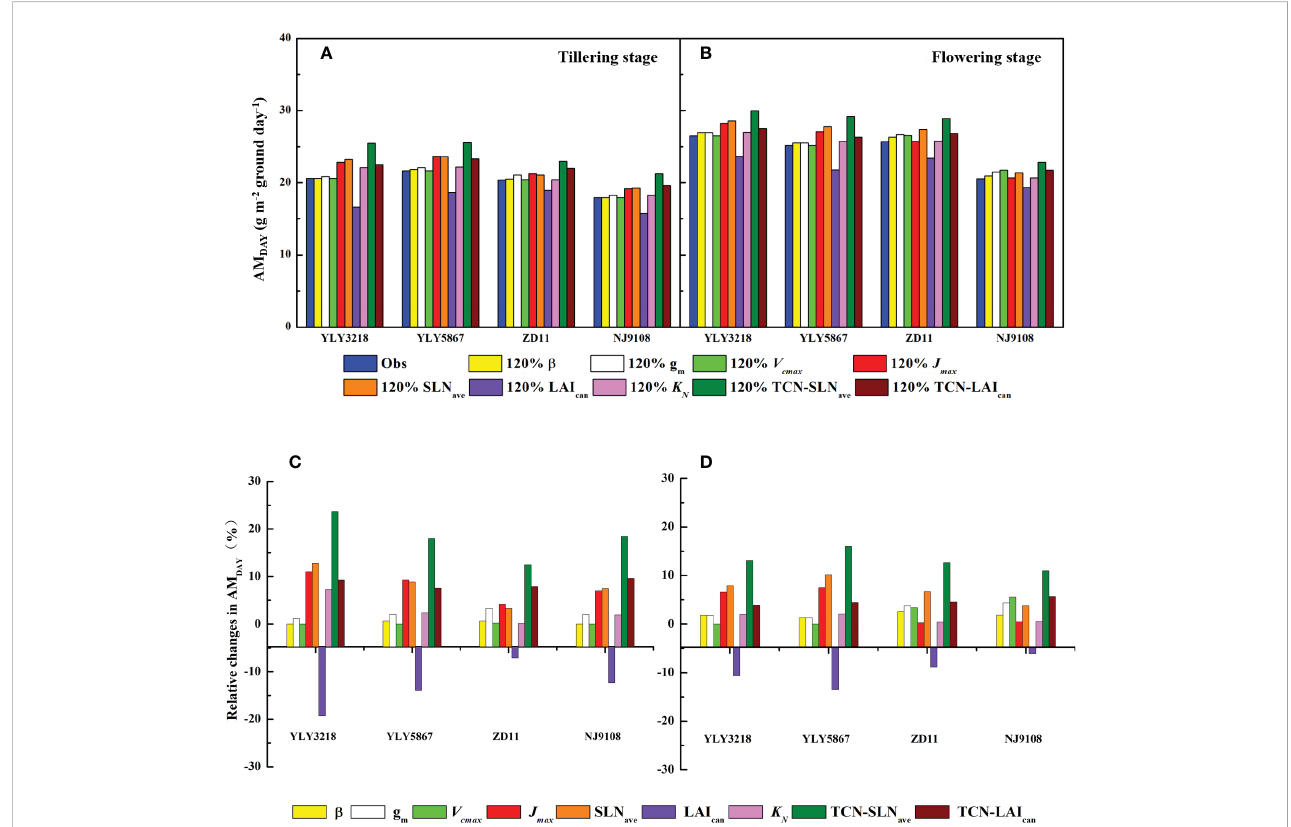
FIGURE 5 AM DAY simulated by 20% enhancement in targeted parameters (A, B) and the corresponding percentage change (C, D) for different rice cultivars during tillering (A, C) and fl owering stage (B, D) . Targeted parameters include canopy average leaf inclination relative to the horizontal ( b ), mesophyll conductance ( g m ), maximum carboxylation rate ( V cmax ), maximum electron transfer rate ( J max ), average canopy nitrogen concentration per unit leaf area